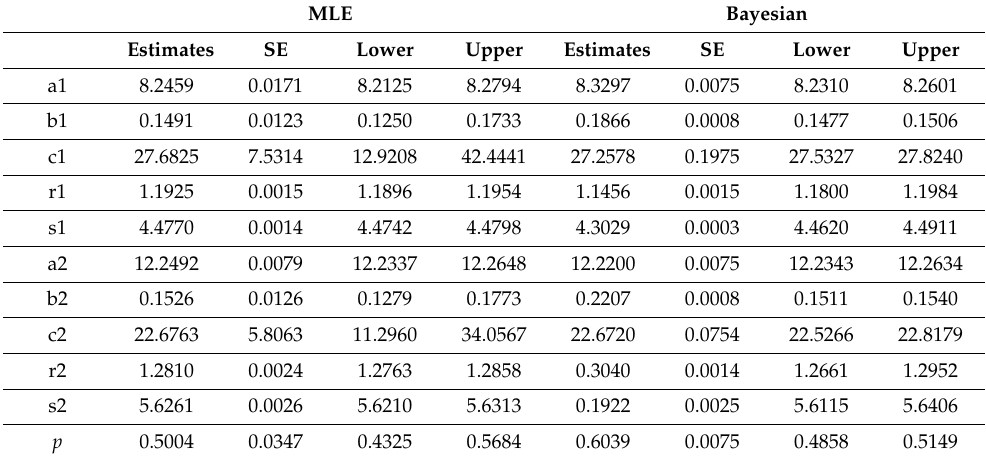
Table 9. ML estimates of the MEKW parameters for the complete sample of the bladder data.